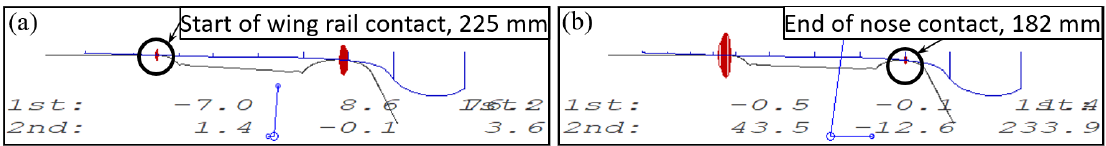
Figure 22. Transition region calculation of a 1:9 trailing crossing in the designed condition: ( a ) start of the contact with the wing rail and ( b ) end of the contact with the nose rail.